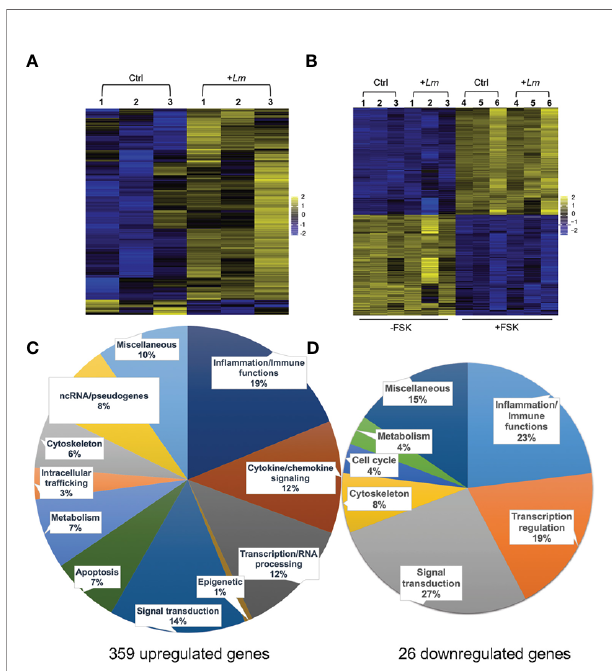
FIGURE 5 | RNAseq analysis of L. monocytogenes infected trophoblasts. Heatmaps of PHT (A) , and FSK-treated (+FSK) or DMSO-treated control (-FSK) BeWo cells (B) , infected for 5 h (+ Lm ) or control non-infected (Ctrl). RNA was extracted from infected and control cells for RNAseq analysis. RNA- seq counts were generated by featureCounts from subread-1.5.1 for genes annotated by GRCh38.92. Count normalization and differential expression was performed using edgeR. Heatmaps were generated by plotting genes with log 2 (FC) > 1 and < -1 and p value < 0.05. Scale is based on log 2 (CPM) from -2 to +2 (n = 3 placentas, and 3 independent experiments involving BeWo cells). Genes were clustered based on similarity of expression pro fi les. (C, D) The upregulated and downregulated DEG were classi fi ed based on their known